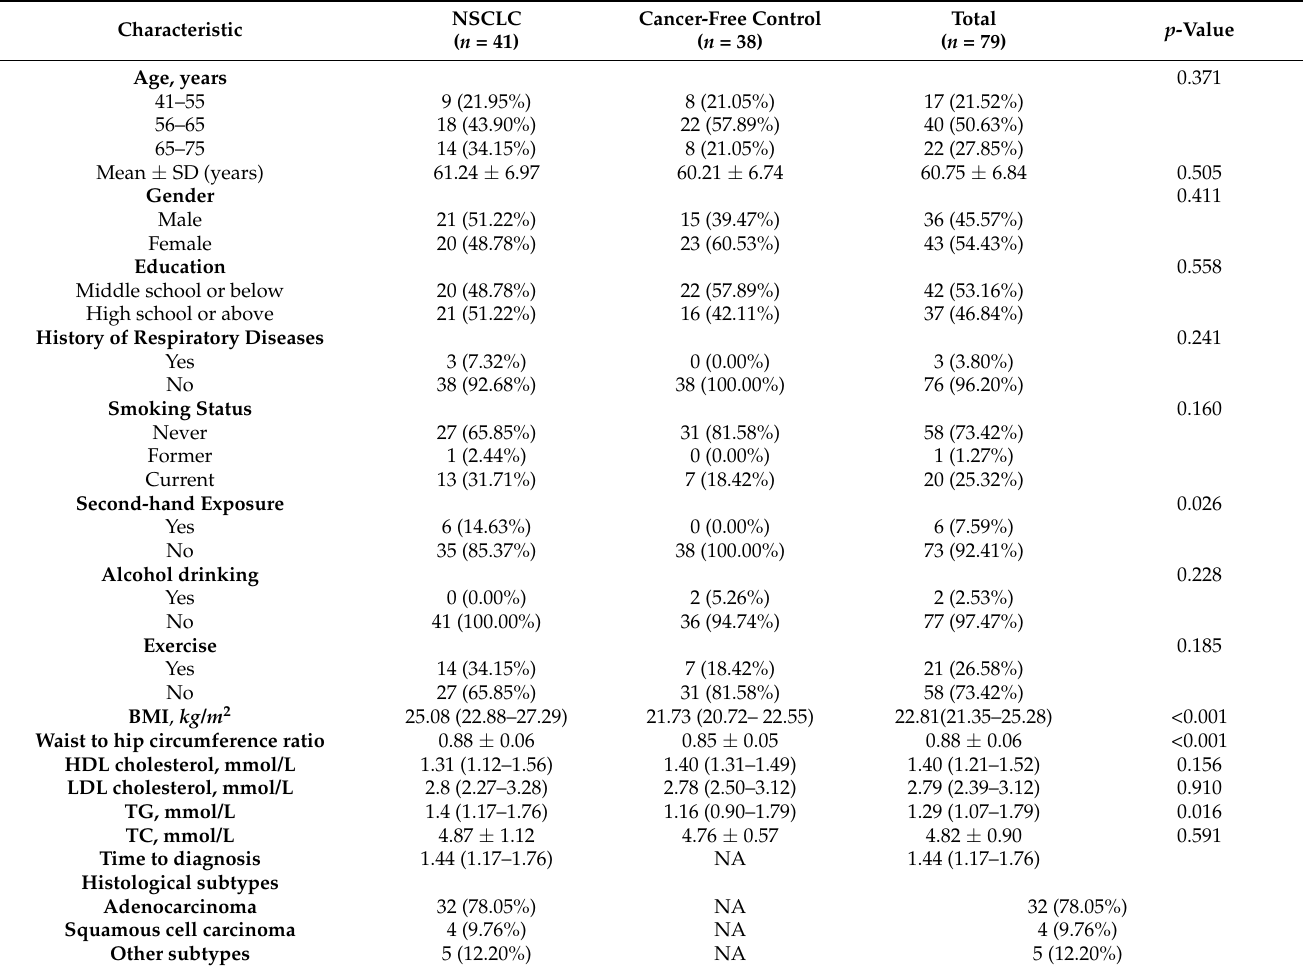
Table 1. Characteristics of the study